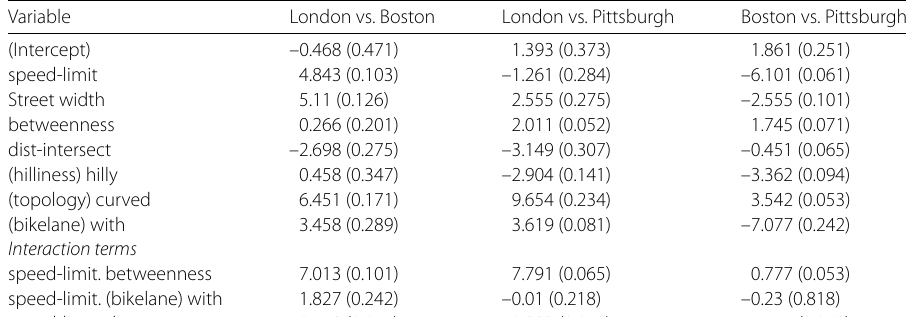
Table 4 Difference in regression coefficients and corresponding p -value Variable London vs. Boston London vs. Pittsburgh Boston vs. Pittsburgh (Intercept) –0.468 (0.471)